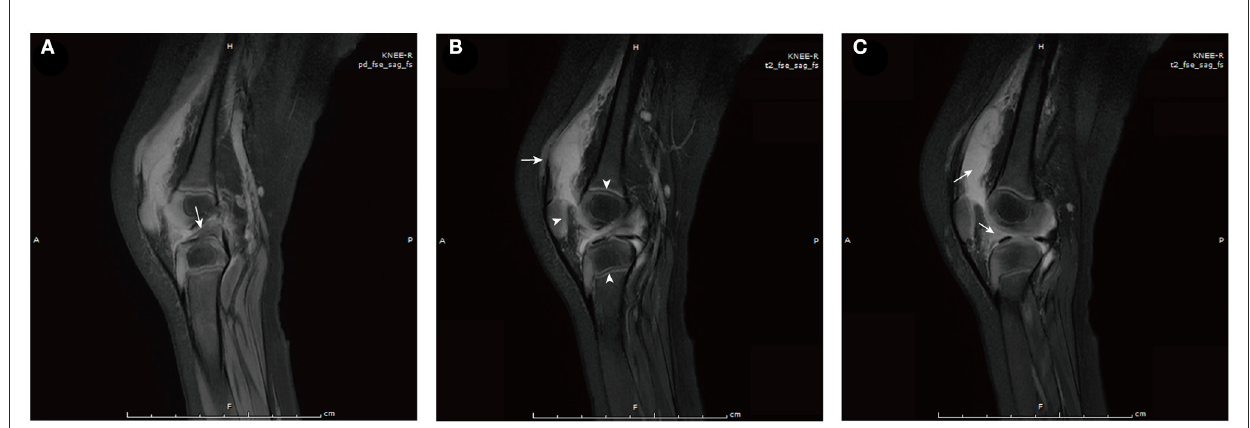
FIGURE1 MRI of the right knee [proton density-weighted (A) and T2-weighted (B, C) ]. (A) Edema of the anterior cruciate ligament (arrow). (B) Soft tissue around the lower segment of the femur was swollen (arrow). Arrowheads from left to right show abnormal signals in the patella, epiphysis of the femur, and epiphysis of the tibia successively, which may have been caused by infectious disease. (C) Massive effusion is observed in the suprapatellar capsule (left arrow) and joint cavity (right arrow).